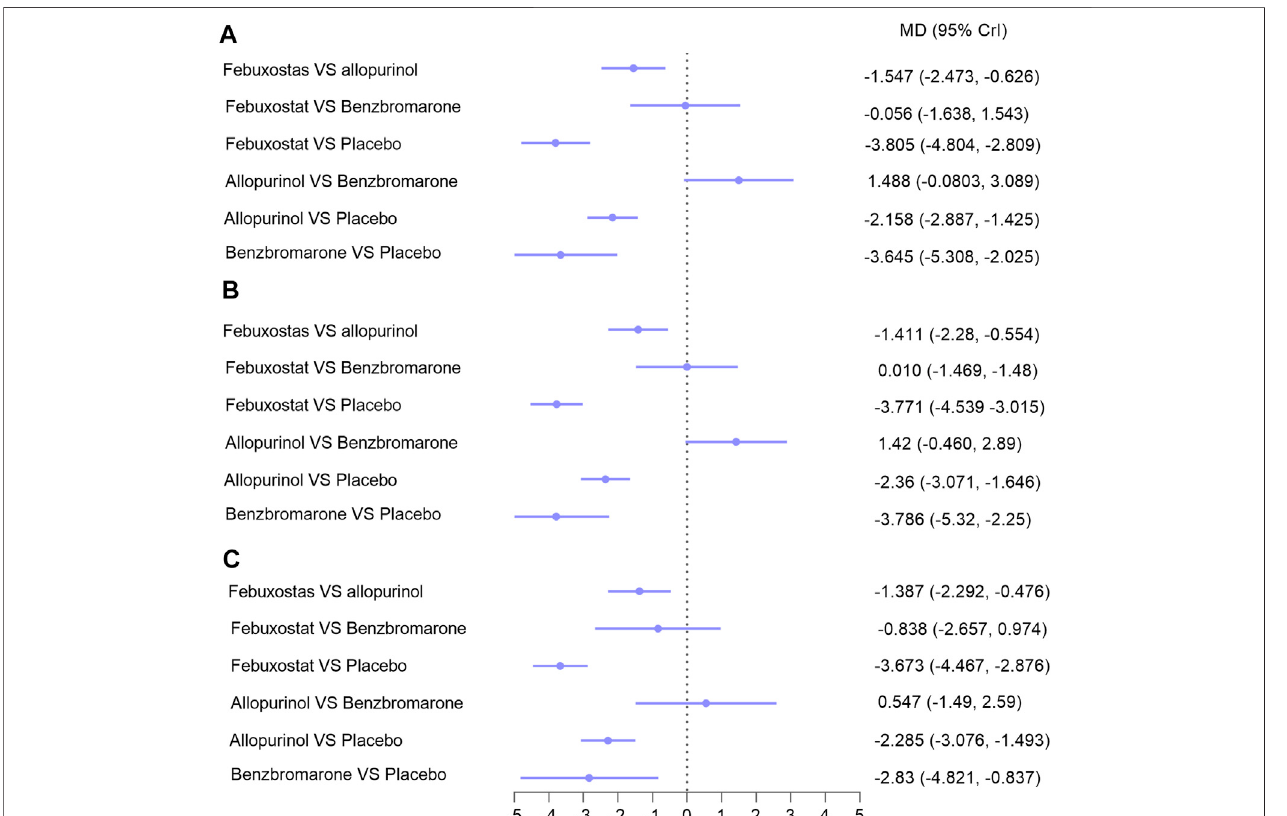
FIGURE3| Networkmeta-analysisresultsforloweringuricacidin (A) patientswithCKD; (B) patientswithhyperuricemiaandCKD; (C) patientswithhyperuricemia and eGFR < 60 ml/min/1.73 m 2 . Abbreviations: MD, mean difference; CrIs, credible intervals; CKD, chronic kidney disease; eGFR (ml/min/1.73 m 2 ), estimated glomerular fi ltration rate.